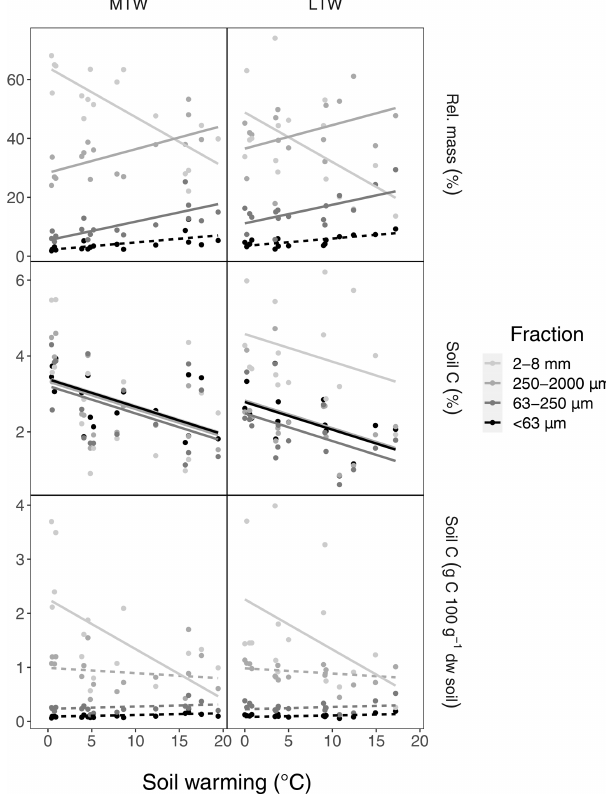
Figure 3. Relative mass, soil C concentration and absolute soil C amount of soil aggregate fractions originating from topsoil in the medium-term warmed (MTW) and long-term warmed (LTW) grassland. Darker lines indicate smaller fractions. Fractions signif- icantly affected by soil warming are represented with solid lines; non-significant relations upon soil warming are shown with dashed lines. The full soil warming range is used here to make optimal use of the smaller sample number for aggregate data. ( n = 17 and n = 16 for each fraction in MTW and LTW grassland